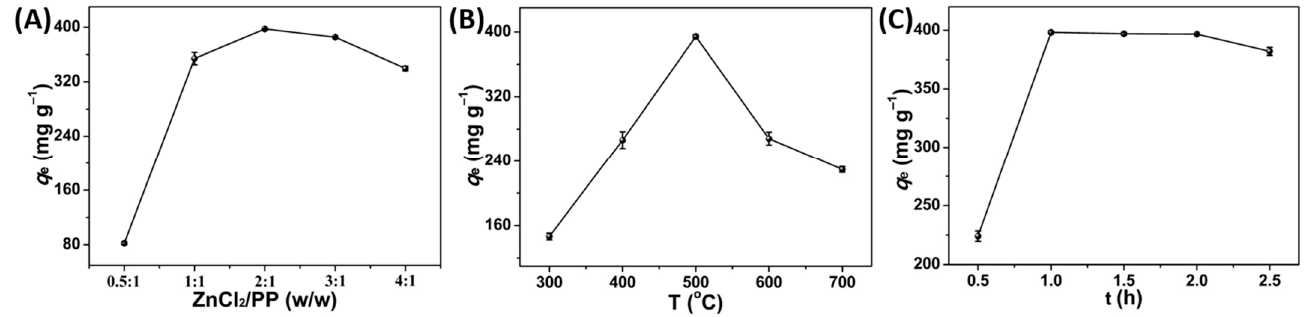
Figure 2. Effect of ( A ) MRZP (T: 500 °C, t: 1 h), ( B ) T (MRZP: 2:1, t: 1 h), and ( C ) t (MRZP: 2:1, T: 500 °C) for MB adsorption on PPPC (pH: 12, c 0 : 200 g L − 1 , 2 h, 25 °C).